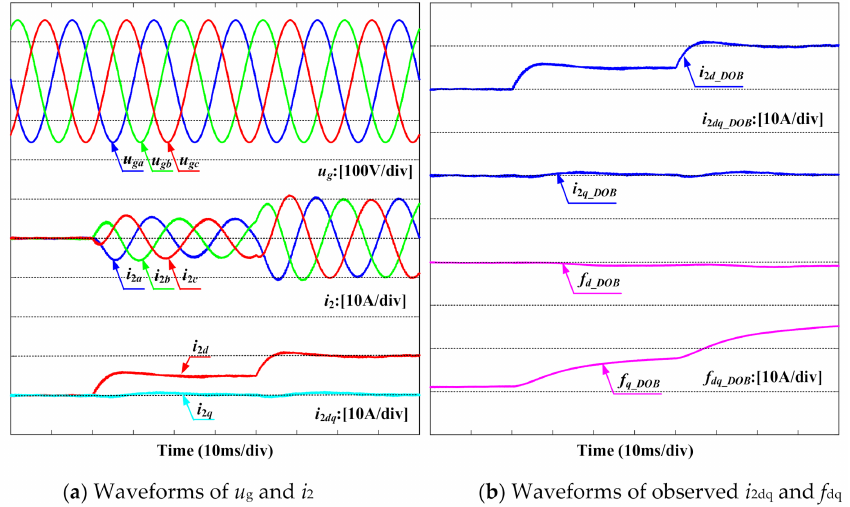
Figure 11. Simulation waveforms for nominal discharging operation.